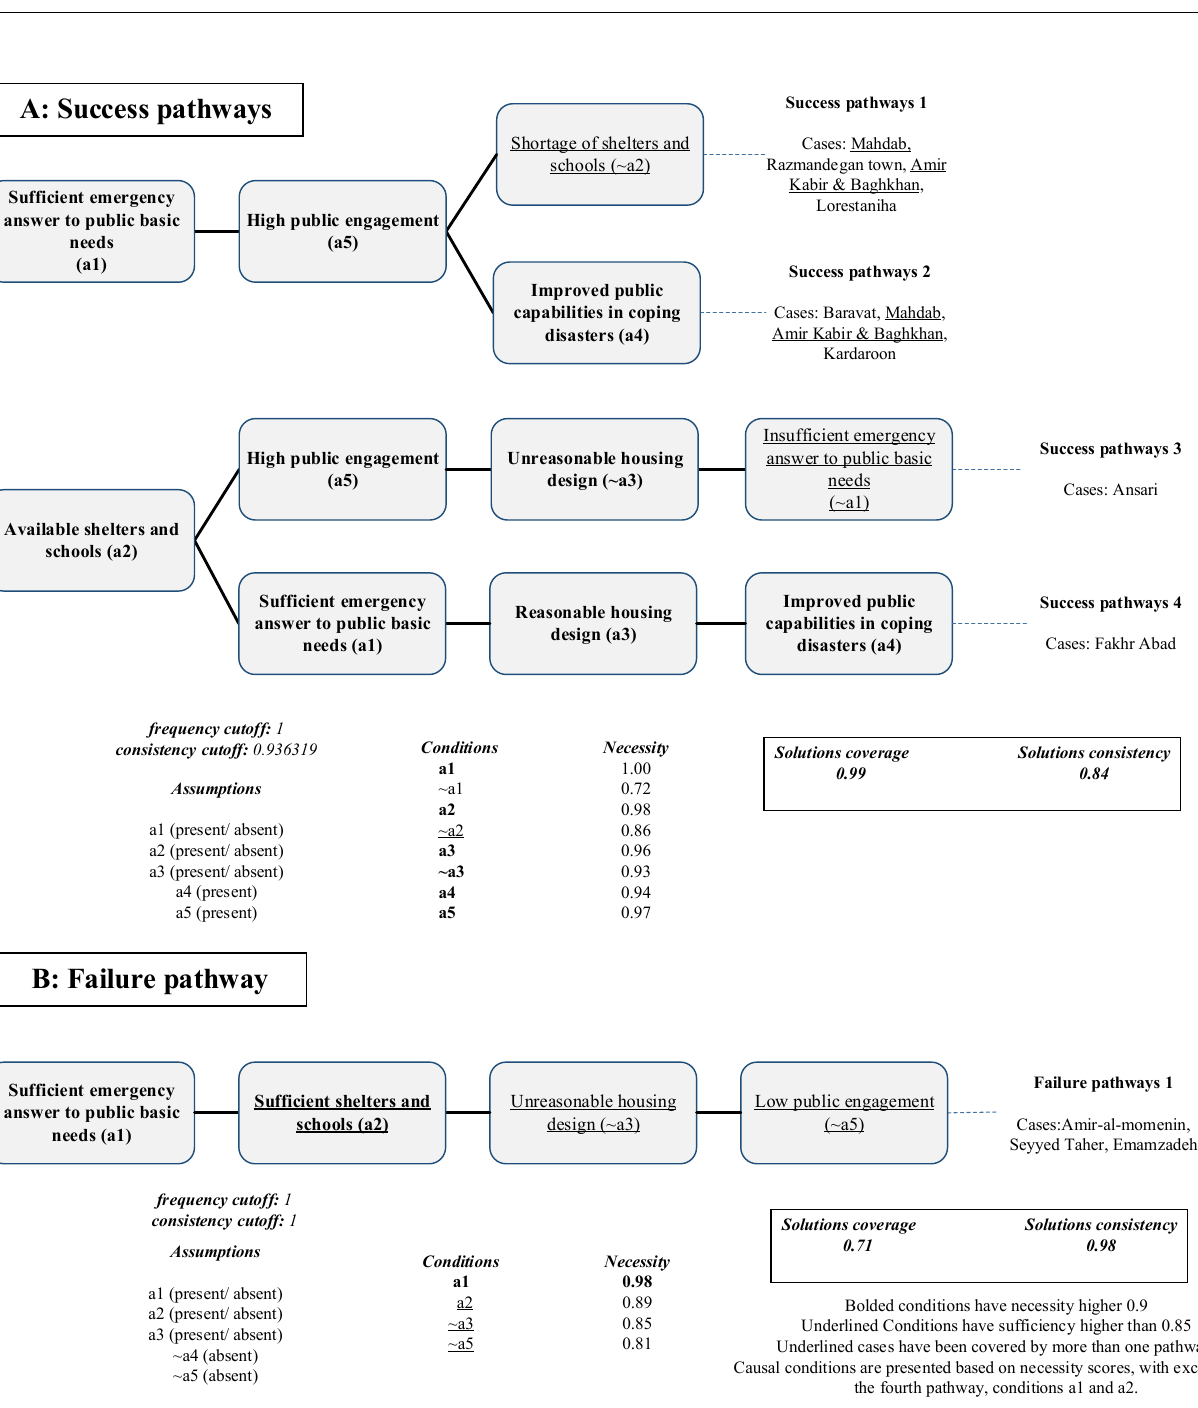
Figure 7. Success and failure pathways for outcome A3. Looking at the pathways, emergency response to basic public needs (condition a1), and availability of shelters and schools (a2) appeared across the majority of the